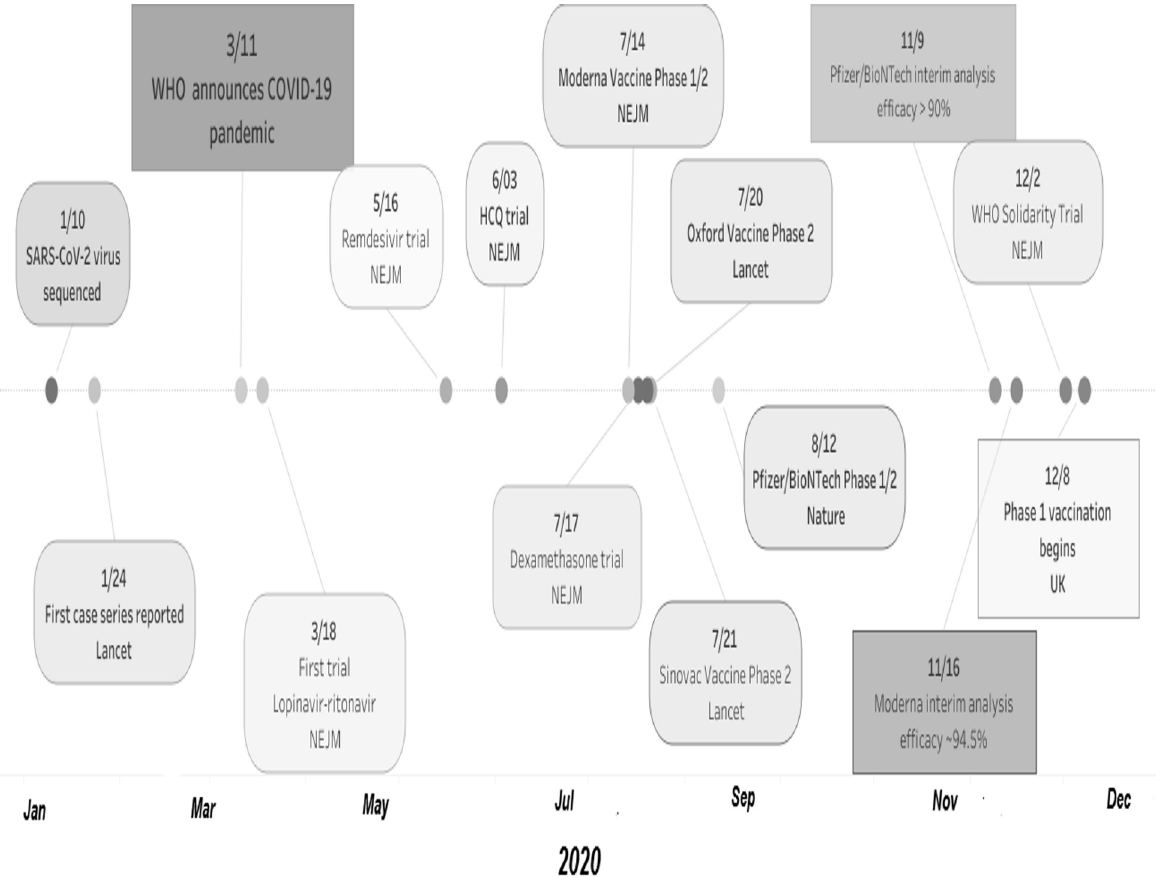
Figure 6. Timeline of the milestone events of the COVID-19 pandemic and related scientific